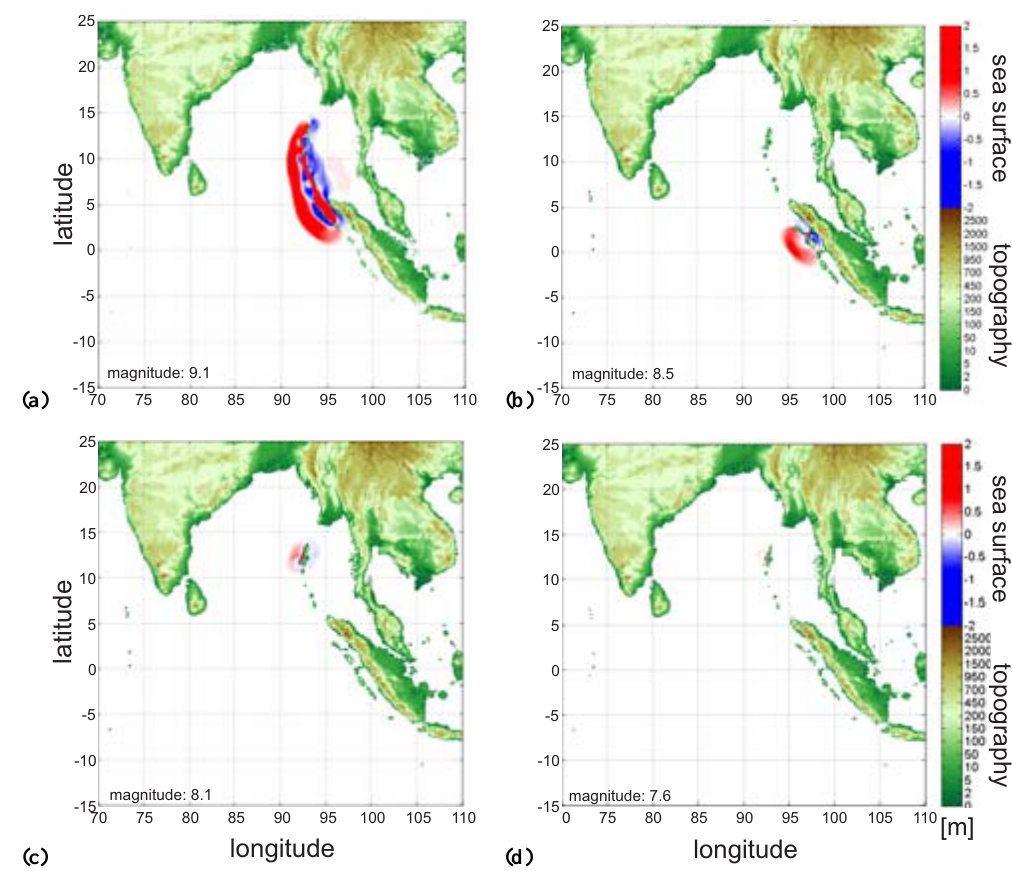
Fig. 5. Tsunami wave propagation simulations of the four strongest historic tsunamis in the Indian Ocean listed in Table 2. The figures show the situation after 15min. The tsunami events in (c) and (d) are at the same location but modeled with different magnitudes.